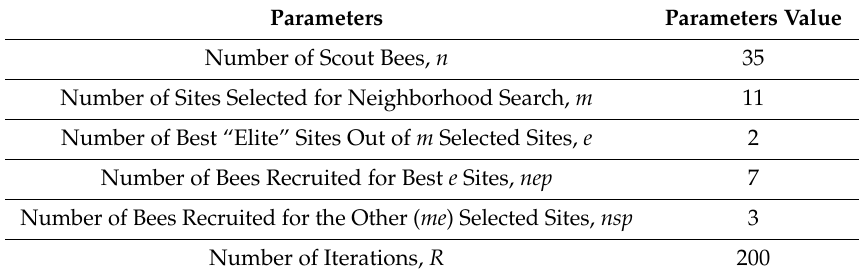
Table 5. Parameters used in the user clustering using swarm artificial bee colony (ABC) algorithm.